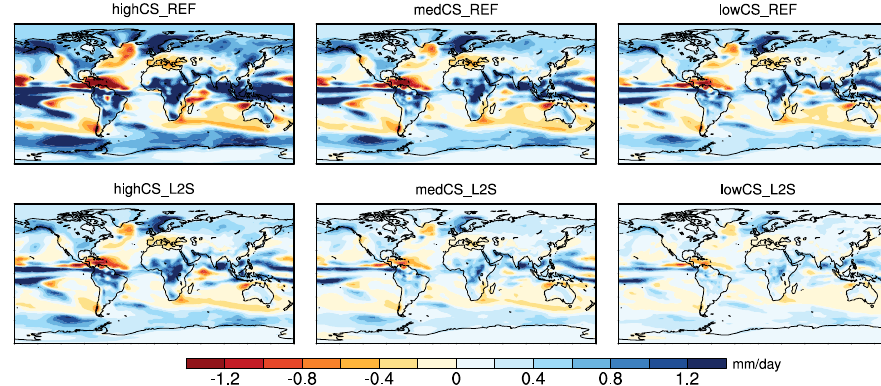
Fig. 17. Same as Fig. 15 but for changes in precipitation (mmday − 1 ).